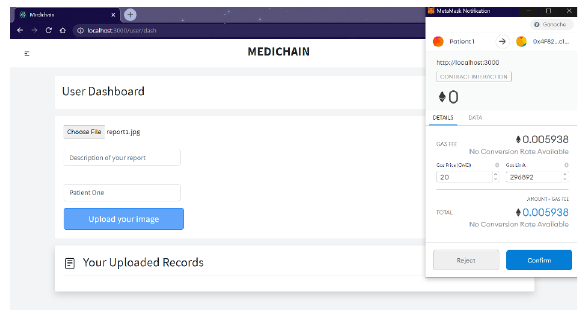
Figure 5. Transaction